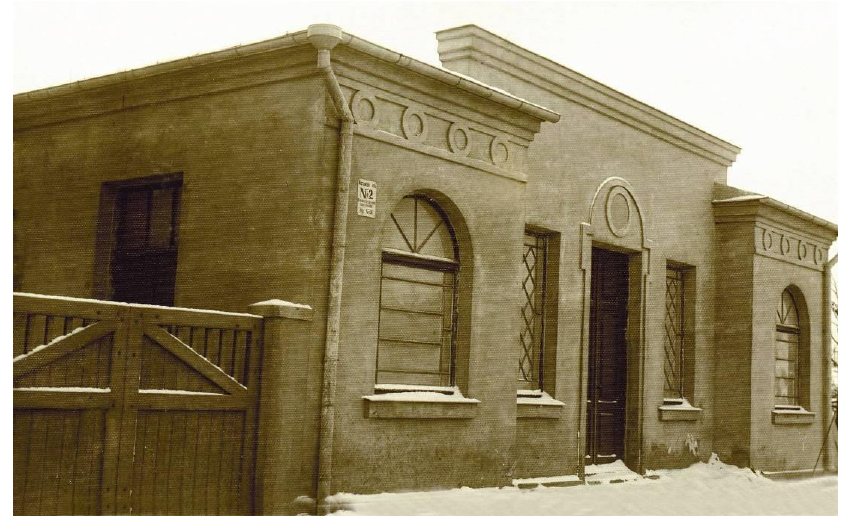
Figure 19. The Hasidic Kloyz in Bauska, ca. 1938. Museum “Jews in Latvia”. Used by permission.